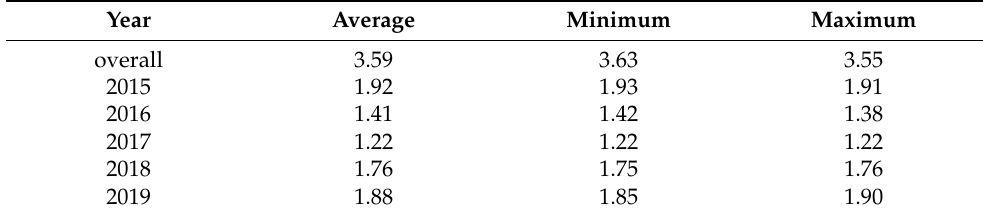
Table 4. The U ratio (GHG U value/electricity emission factor U value).